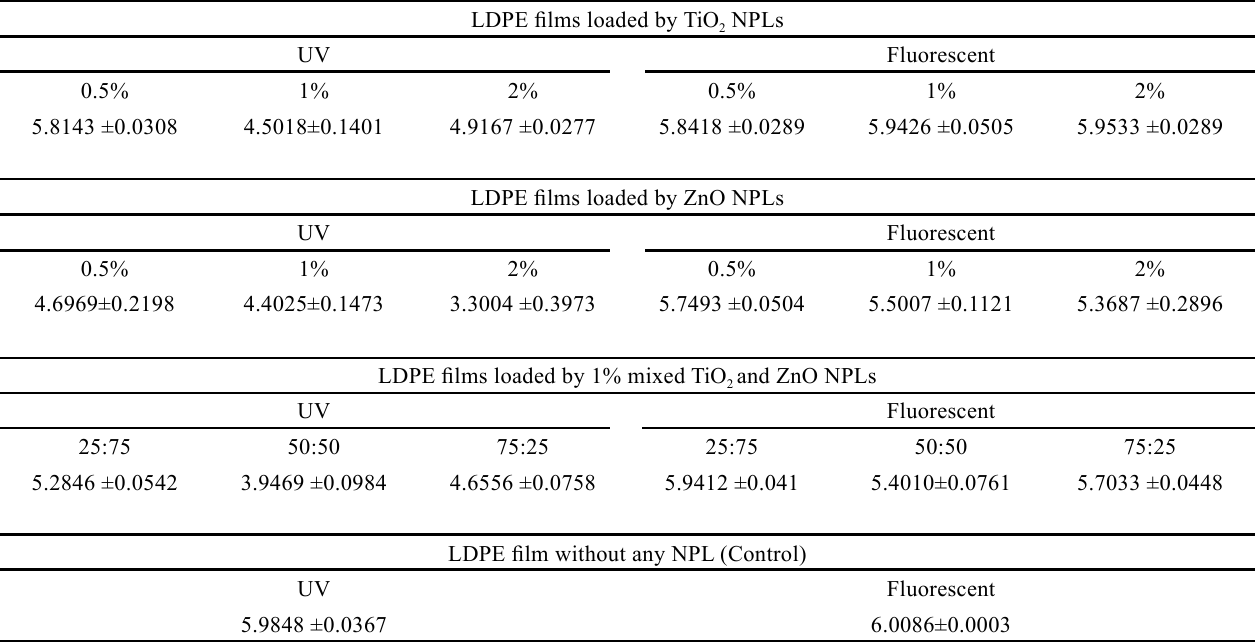
Table 1. The mean values of S. aureus colony counts (log CFU/g) for direct effect of LDPE films loaded by various dosages of ZnO and TiO NPLs after 72 hr exposed under fluorescent and UV light at 20 o C inside the testing tubes.